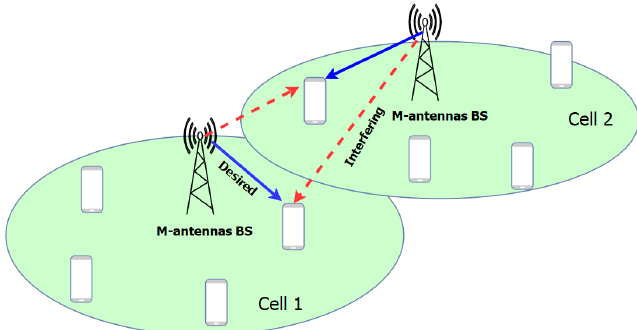
Figure 1. Multi-cell massive Multiple Input Multiple Output (MIMO) network system